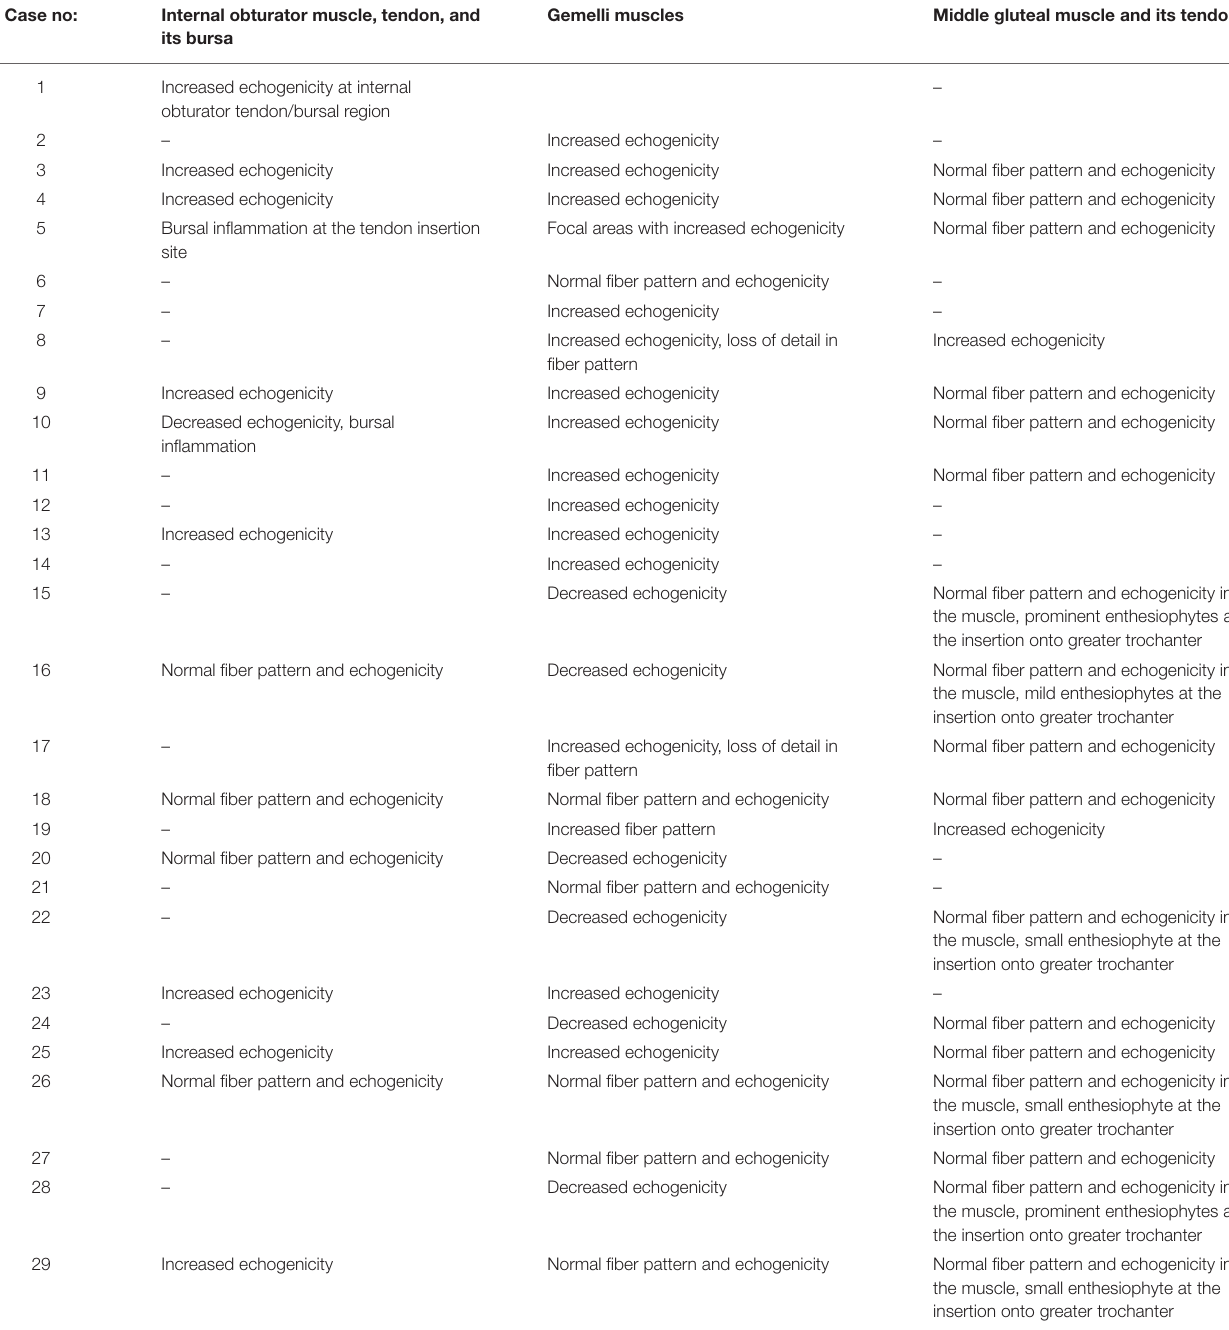
TABLE 4 | Ultrasonographic findings of the internal obturator, gemelli and middle gluteal muscles, affected side. Case